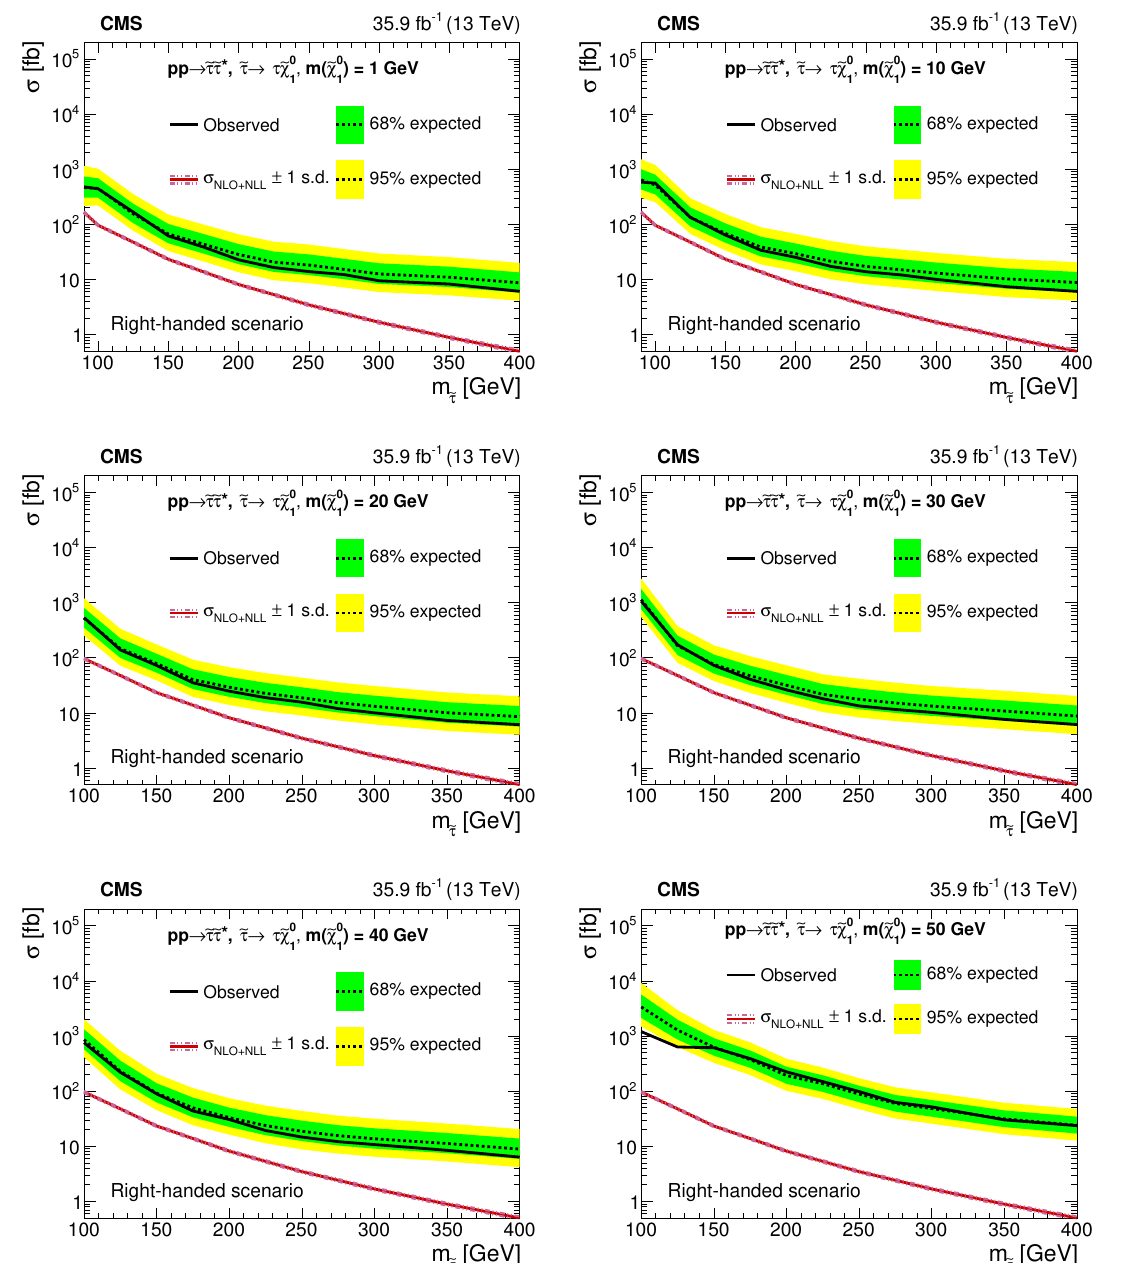
Figure 13. Excluded (cid:28) pair production cross section as a function of the handed (cid:28) scenario, and for di(cid:11)erent (cid:31) 0 masses of 1, 10, 20, 30, 40, and 50 GeV from upper right to 1 lower right, respectively. The inner (green) band and the outer (yellow) band indicate the regions e containing 68 and 95%, respectively, of the distribution of limits expected under the background- e e only hypothesis. The red line indicates the NLO+NLL prediction for the signal production cross section calculated with Resummino [47], while the red hatched band represents the uncertainty in the prediction.